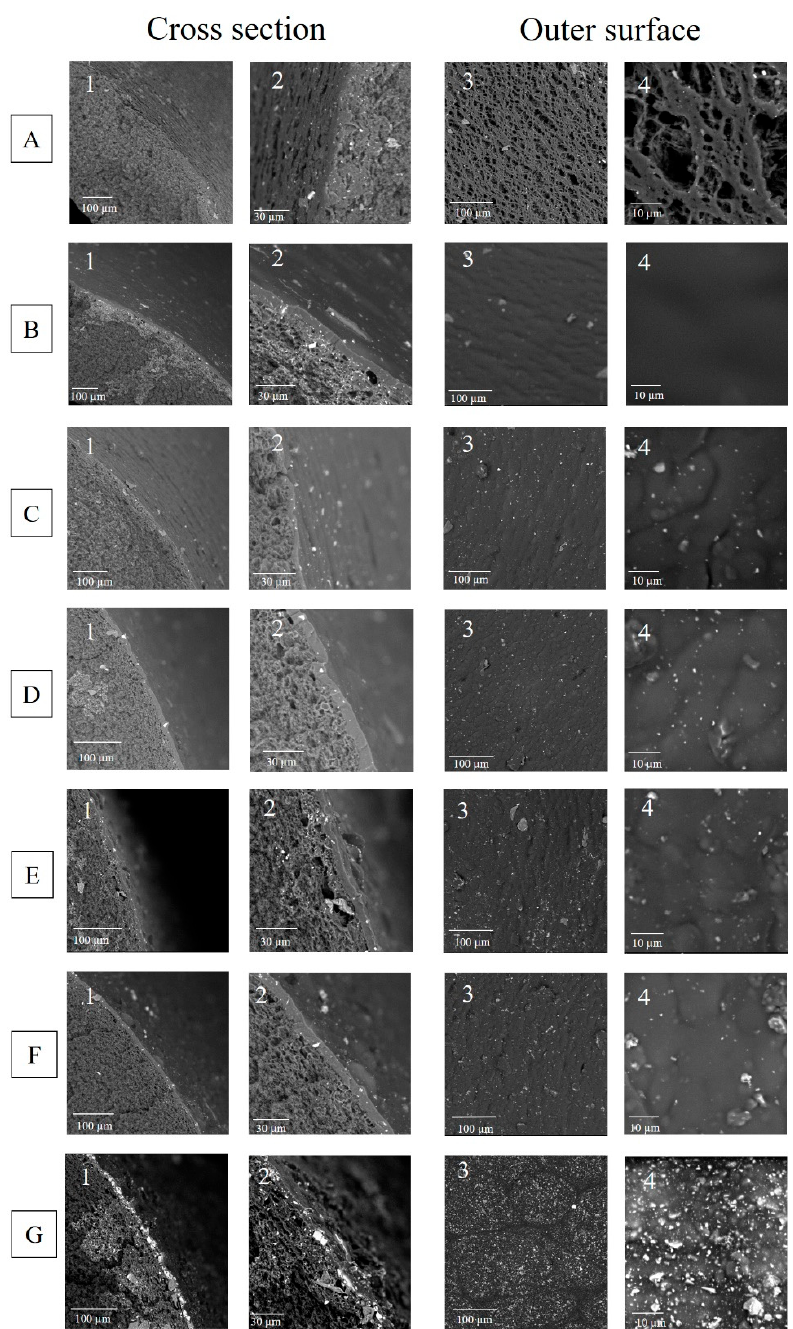
Figure 7. SEM pictures of cross-section (1 and 2) and outer surface (3 and 4) of Pebax ® 2533-UiO- 66-NH 2 /PP thin film mixed matrix hollow fiber membranes—( A ) PP hollow fiber support, ( B ) 0 wt% UiO-66-NH 2 , ( C ) 5 wt% UiO-66-NH 2 , ( D ) 10 wt% UiO-66-NH 2 , ( E ) 15 wt% UiO-66-NH 2 , ( F ) 20 wt% UiO-66-NH 2 , and ( G ) 50 wt% UiO-66-NH 2 .